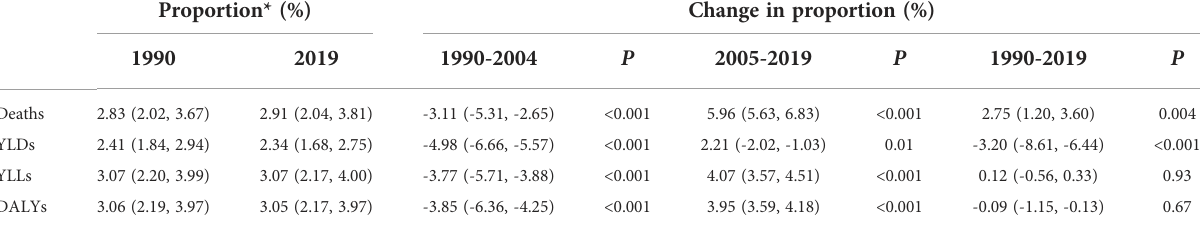
TABLE 2 Contribution of cancer burden caused by secondhand smoke to total cancer burden caused by all risk factors for both sexes between 1990 and 2019. Proportion*